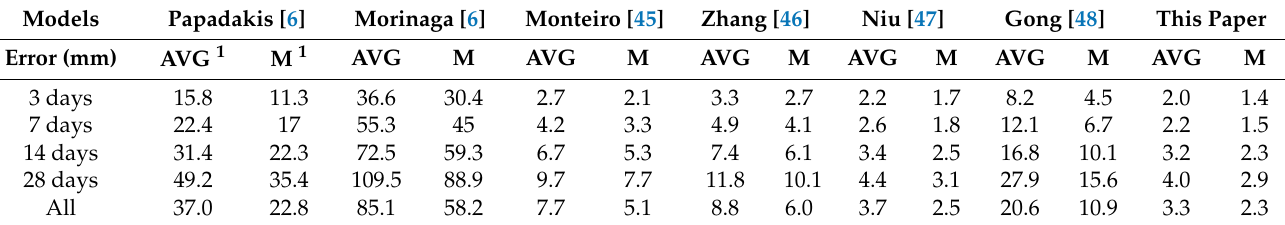
Table 5. Results of different models.